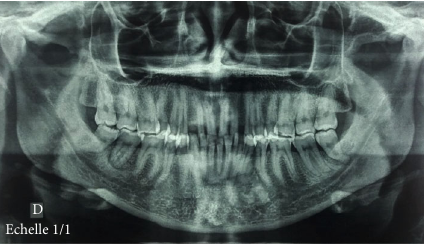
1/1D Echelle Figure 2: Preoperative orthopantomogram revealing a radiolucent lesion associated with radiopaque content regarding the